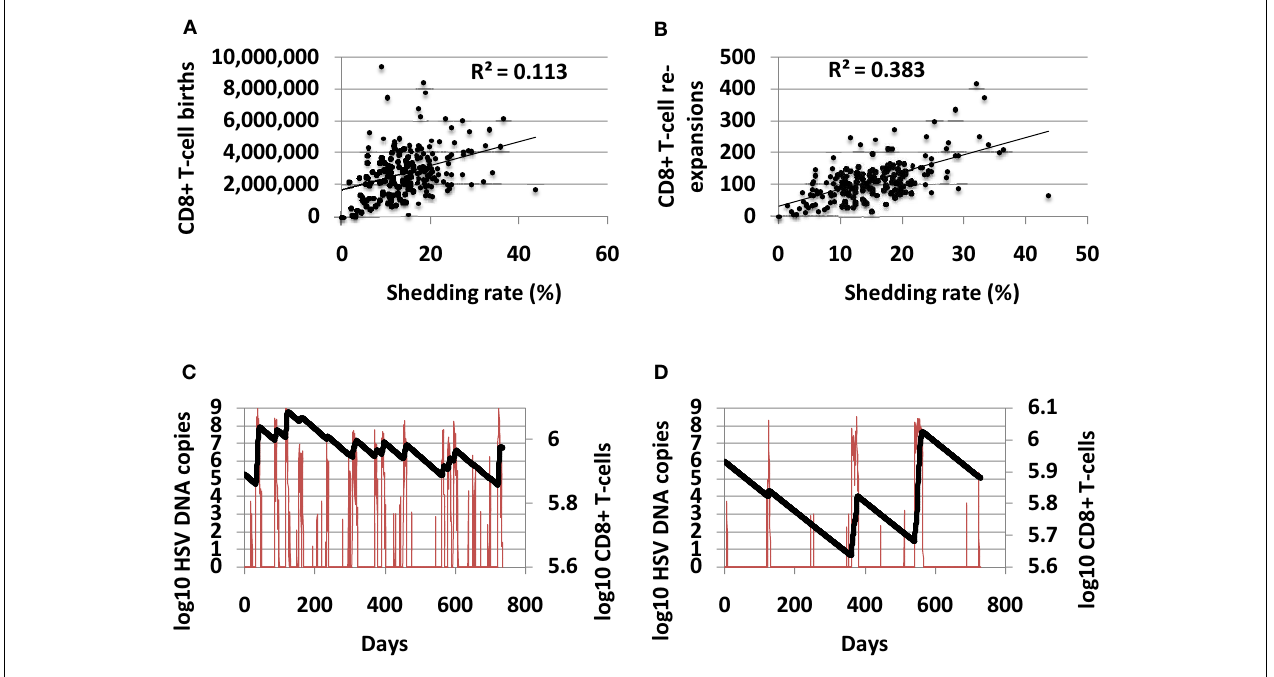
example of a high shedder (HSV DNA in red and CD8 + T-cells in black) with frequent CD8 + T-cell reconstitution events. (D) An example of a low shedder (HSV DNA in red and CD8 + T-cells in black) with less common CD8 + T-cell reconstitution events.